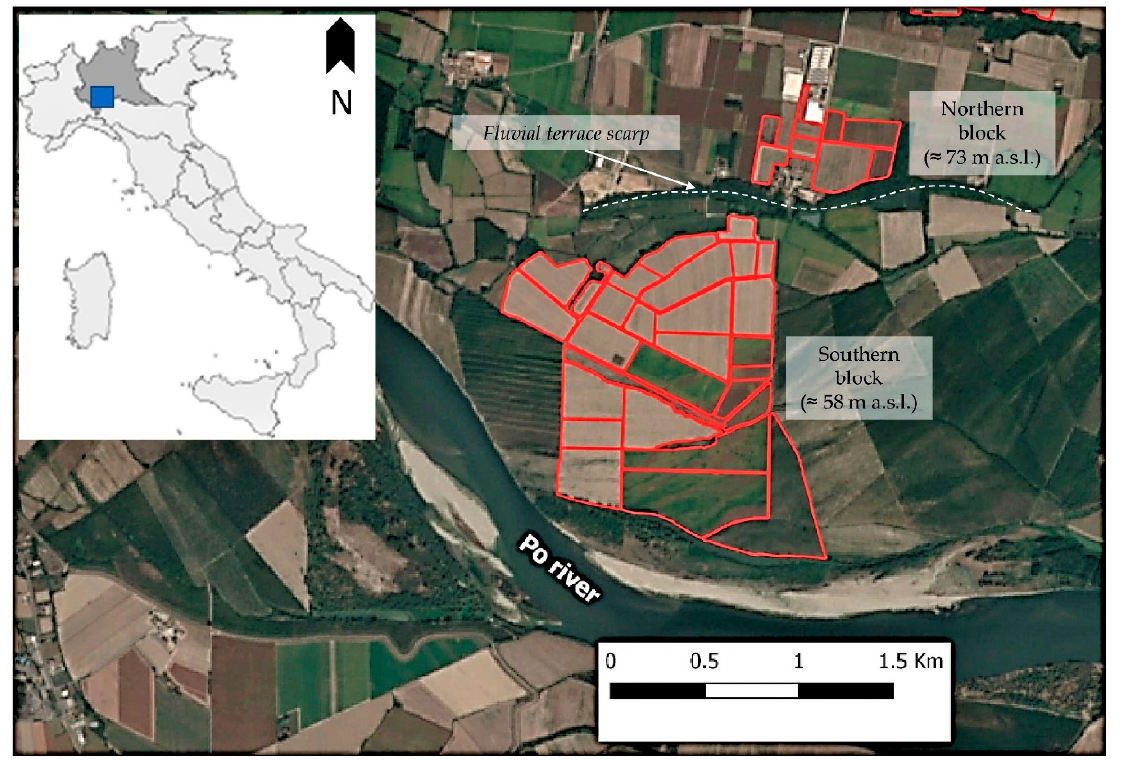
Figure 1. Study area. The fields are delimited by red lines. On average, long term (1981–2010) precipitation data shows an average of 830 mm · year ◦ average annual temperature of 13.5 C. The cropping system of the fields is typical for this area, and